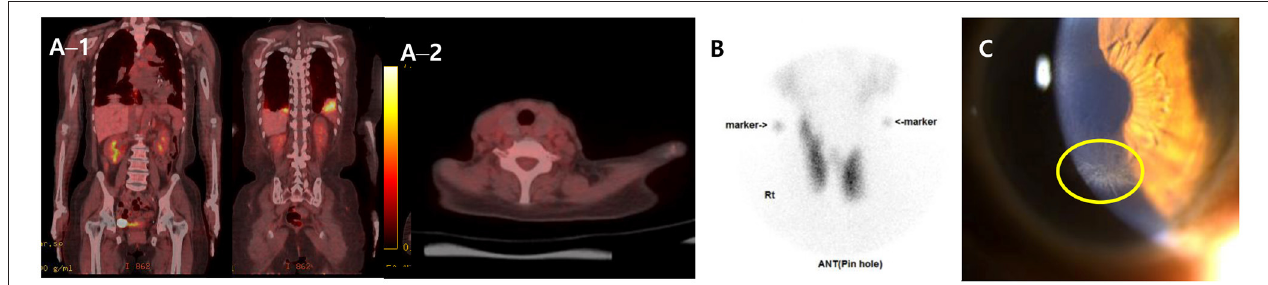
FIGURE 3 | FDG PET–CT, Thyroid scan and ophthalmologic exam. (A) FDG PET–CT scans of the whole body (A − 1) and the thyroid (A − 2) showing multiple hypermetabolic lesion in both lungs and no metabolic lesion in other organ including the thyroid. (B) Thyroid scan (technetium-99m pertechnetate scintigraphy) presenting diffuse homogenous intake of technetium-99m pertechnetate in both thyroid lobes. (C) Slit-lamp biomicroscopy showing numerous dense gray granular lines forming vortex patterns radiating from a median point at the junction of the middle and lower thirds of the cornea. FDG, fluorodeoxyglucose; PET–CT, positron emission tomography–computed